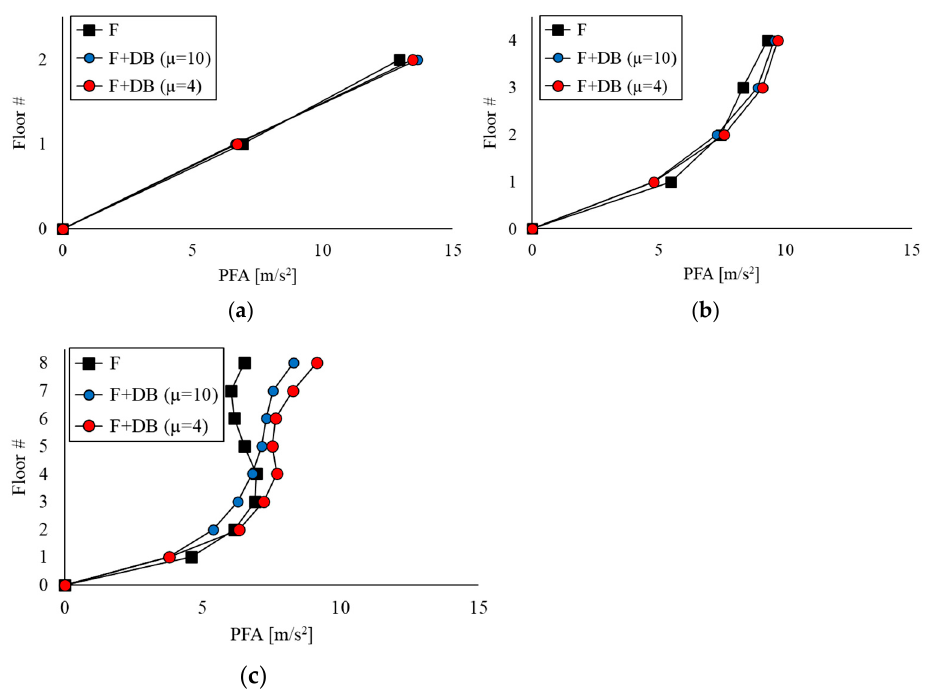
Figure 13. Peak Floor Acceleration of the case-study MRFs with and w/o damped braces: ( a ) two- story, ( b ) four-story, and ( c ) eight-story structures.